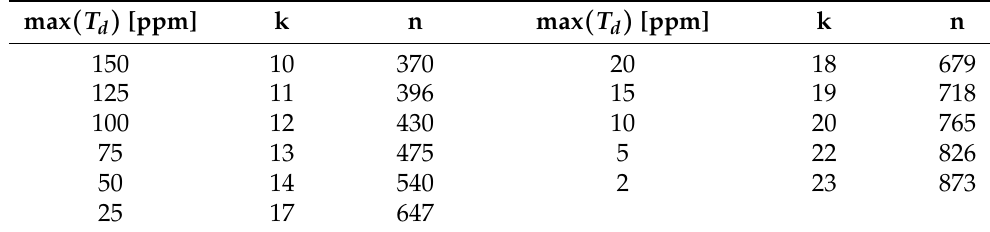
Table 4. Parameter settings scenario S1 and